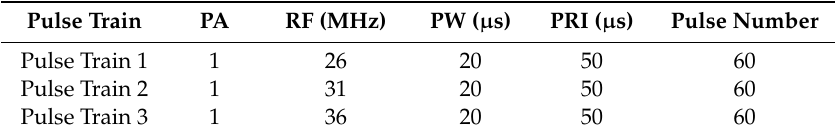
Table 6. Signal parameters of Scene